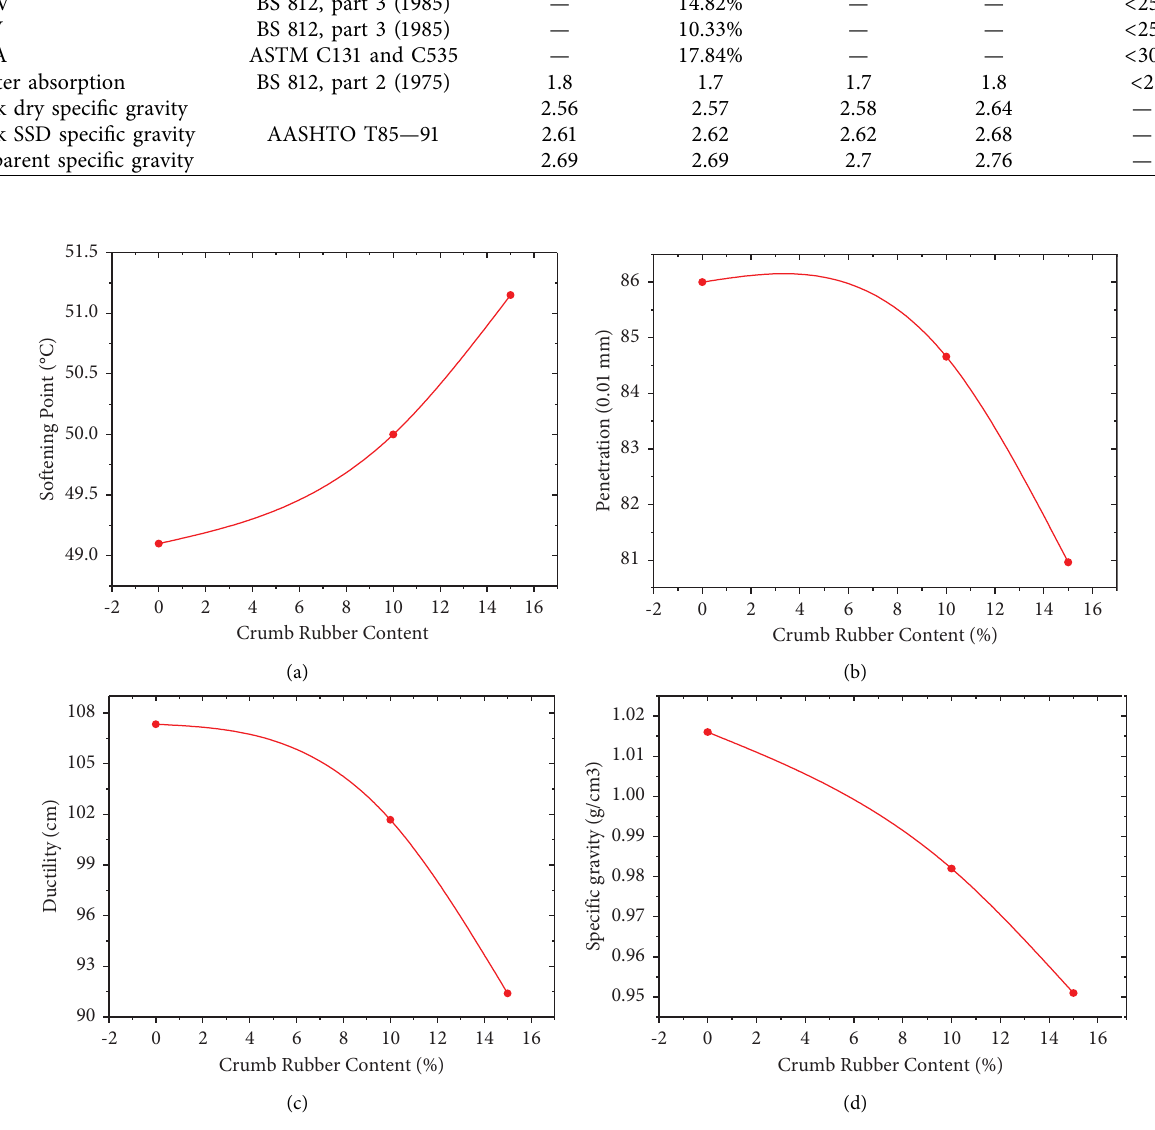
Figure 1: Mechanical properties of the asphalt binder: (a) softening point, (b) penetration value, (c) ductility, and (d) specifc